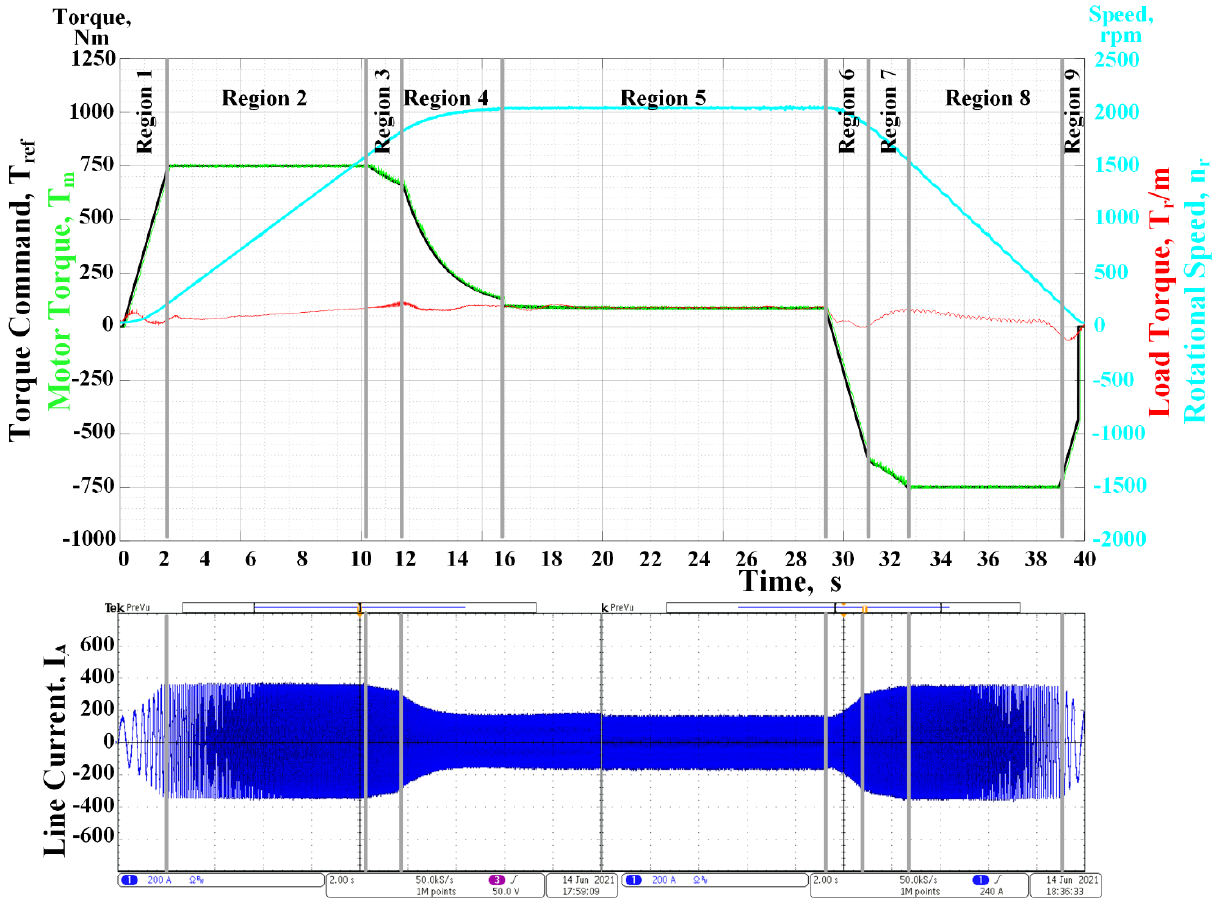
Figure 21. Acceleration, constant speed operation, and then deceleration on a level track Region 1: Starting period, Region 2: Acceleration at maximum torque, Region 3: Acceleration at constant power, Region 4: Controller action for smooth transition from acceleration to constant speed operation, Region 5: Constant speed operation, Region 6: Start of regenerative braking operation, Region 7: Deceleration at constant power, Region 8: Deceleration under maximum braking torque, Region 9: Bringing the vehicle to a stop by mechanical brake.